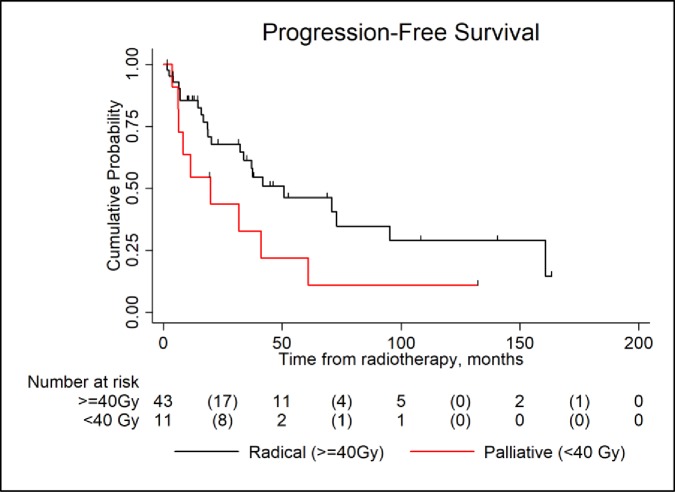
How radiotherapy dose (radical >40Gy, or palliative <40Gy) affects progression free survival (PFS).